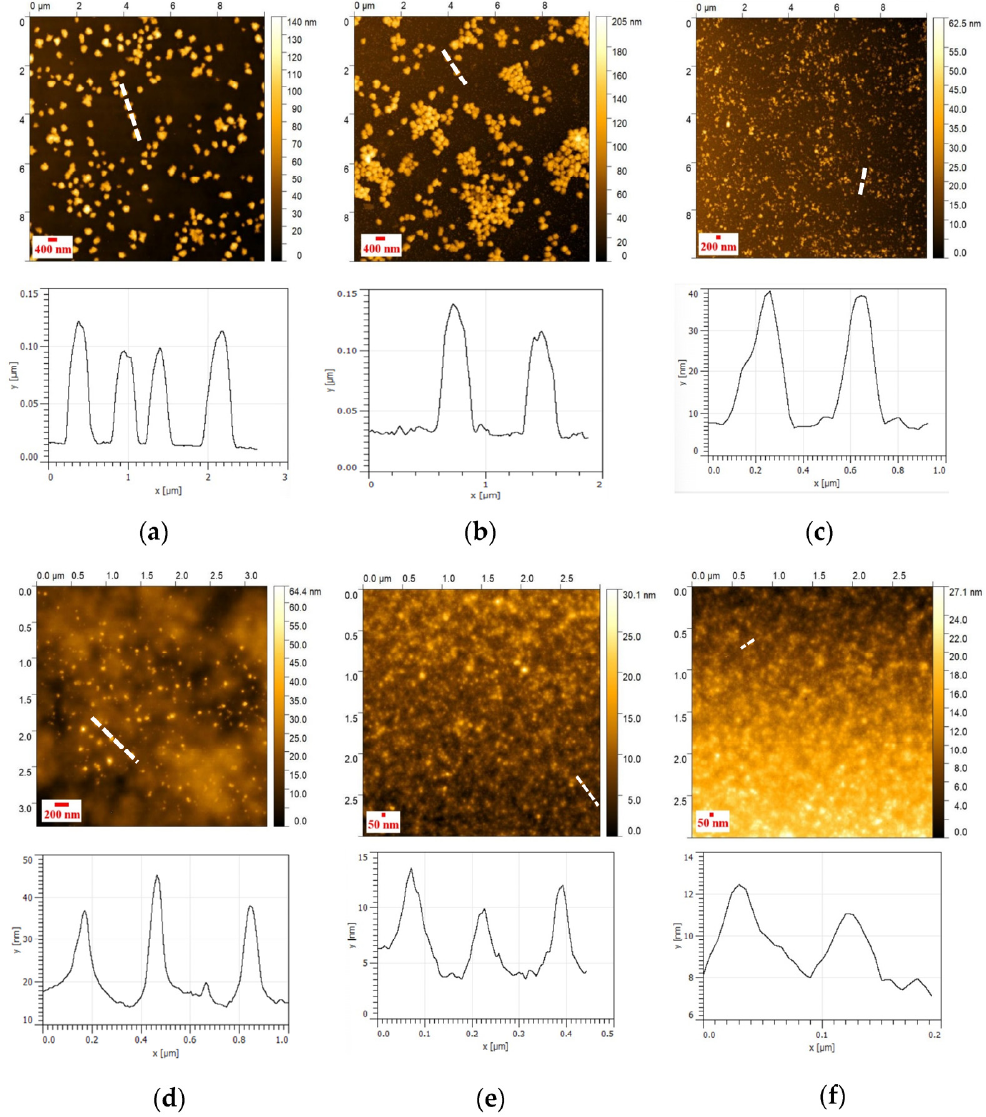
Figure 4. AFM topography images of 400 nm NHG ( a ) original and ( b ) reduced, 200 nm NHG ( c ) original and ( d ) reduced; and 50 nm NHG ( e ) original and ( f )